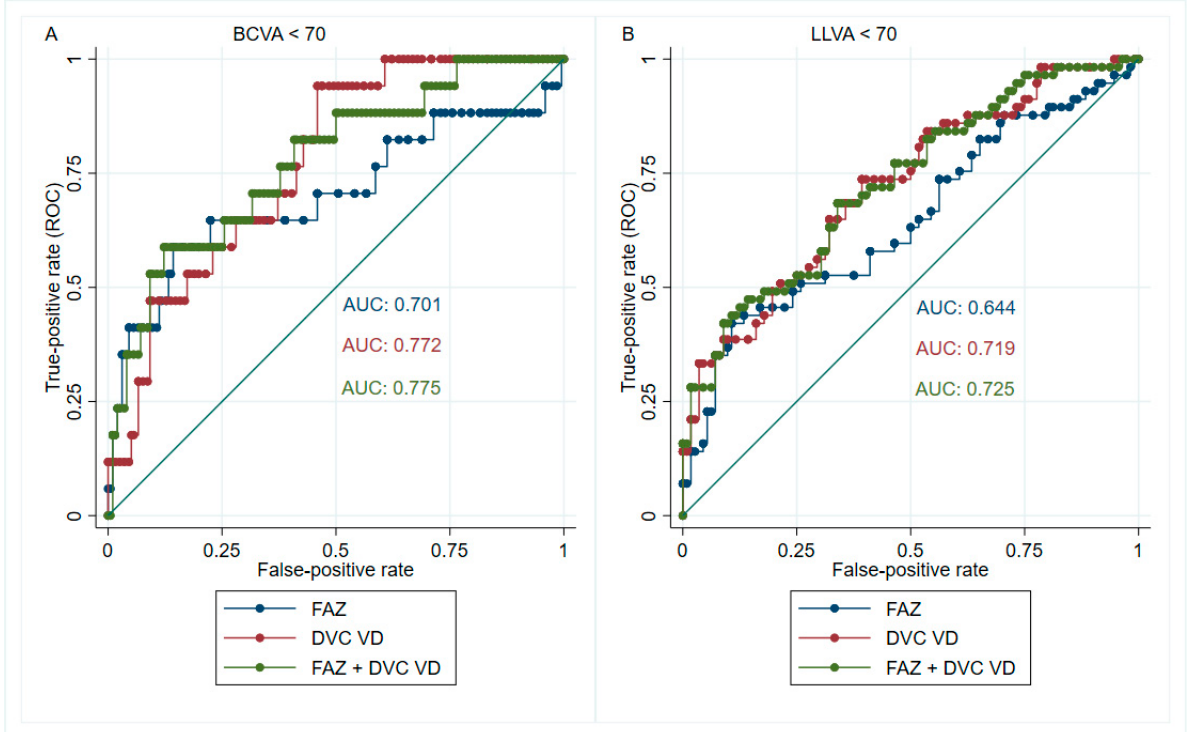
Figure 4. The receiver operating characteristic (ROC) curves for combined parameters in identifying visual impairment. The foveal avascular zone (FAZ) area and the whole image deep vascular complex